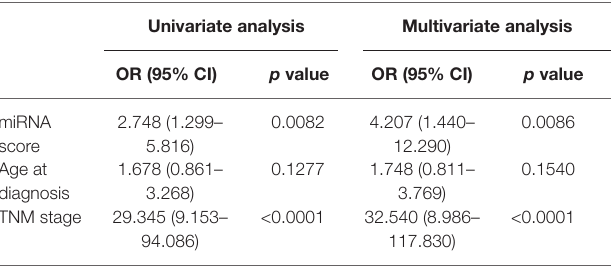
TABLE 4 | Risk factors for lung metastasis in external validation cohort.